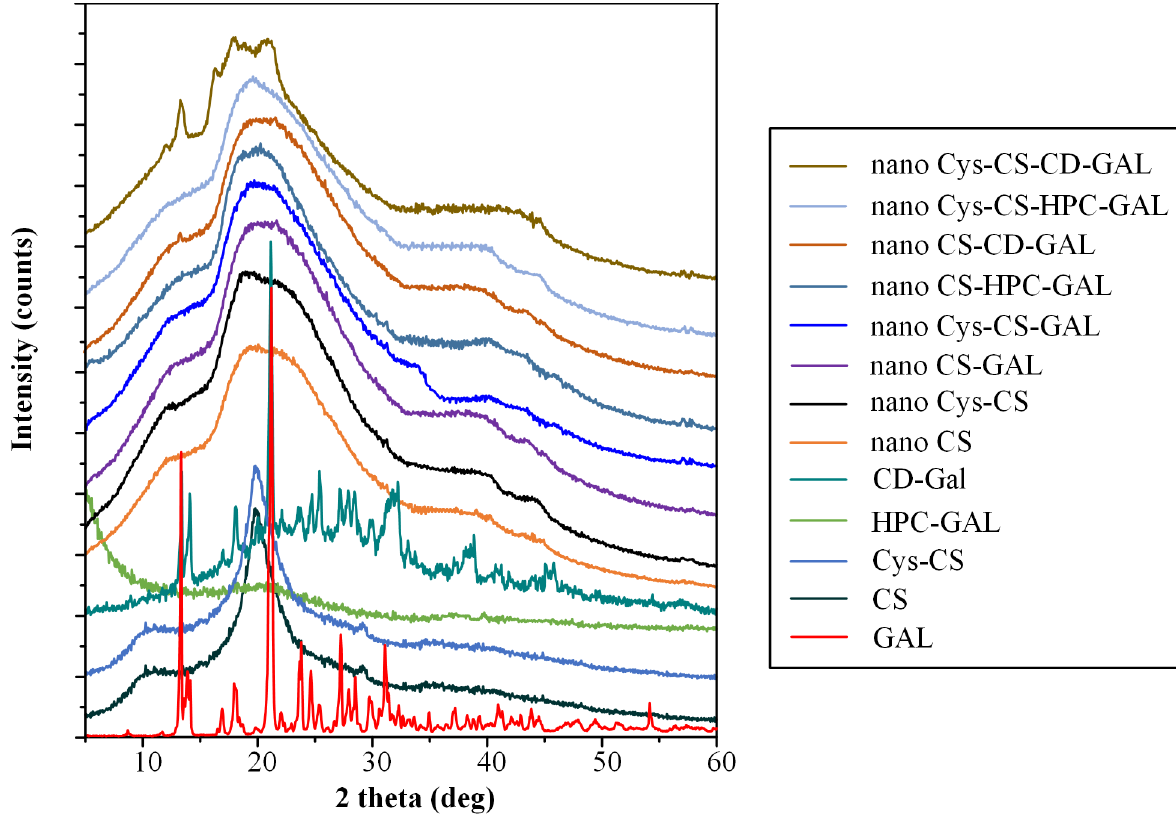
Figure 7. pXRD diffractograms of raw materials and the prepared NPs.